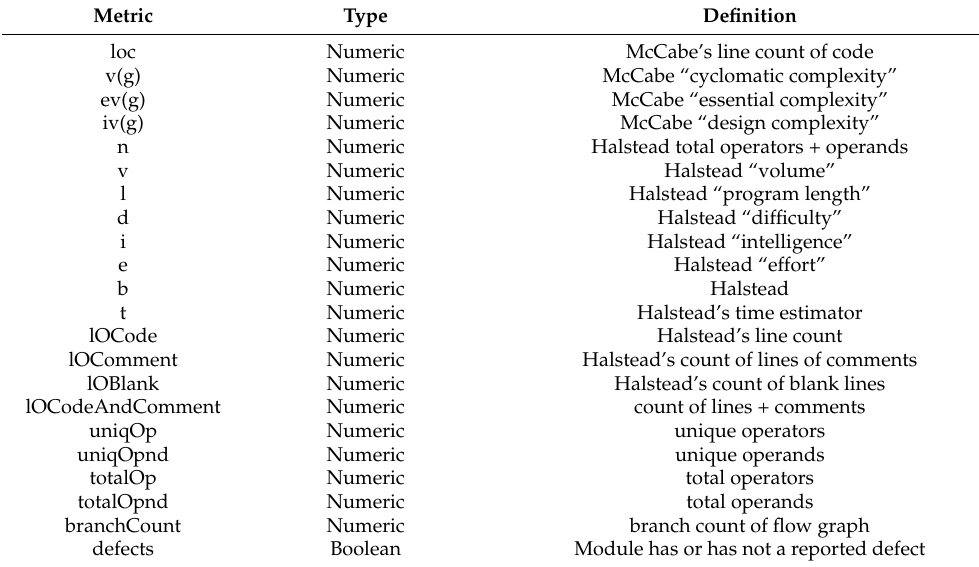
Table 3. Traditional Product Metrics found in the NASA Metrics Data Program repository.